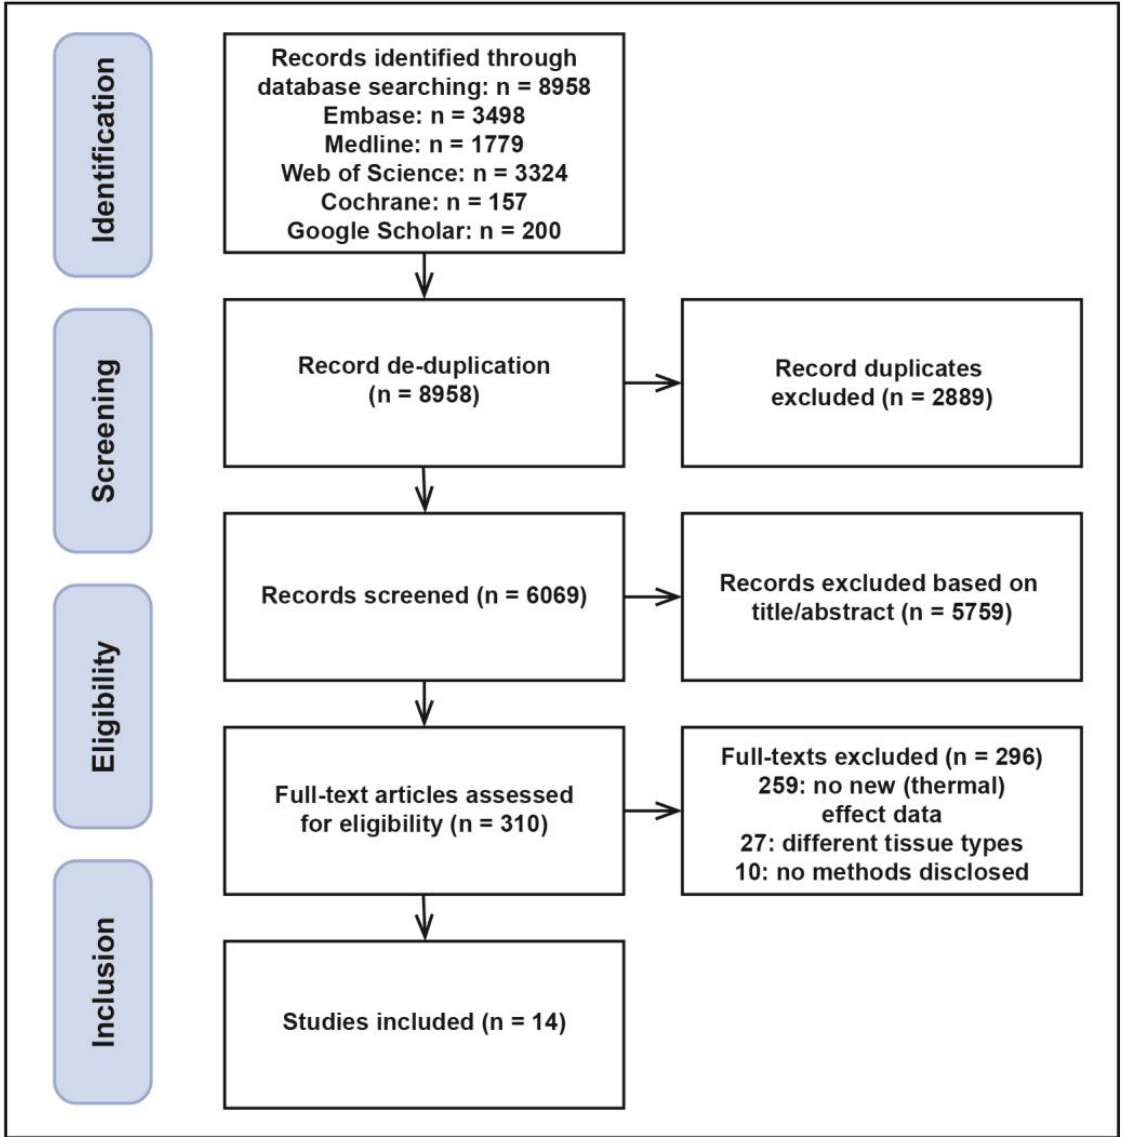
Figure 1. PRISMA flowchart indicating the selection of articles for this systematic review.